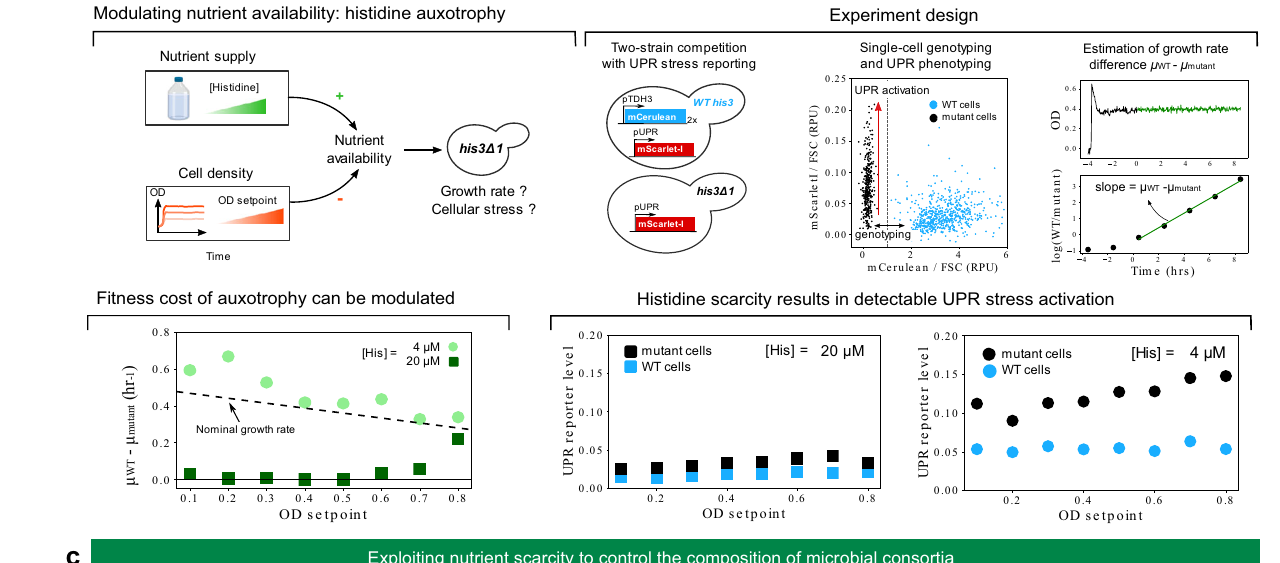
Dynamic control of OD to maintain distinct strain ratios